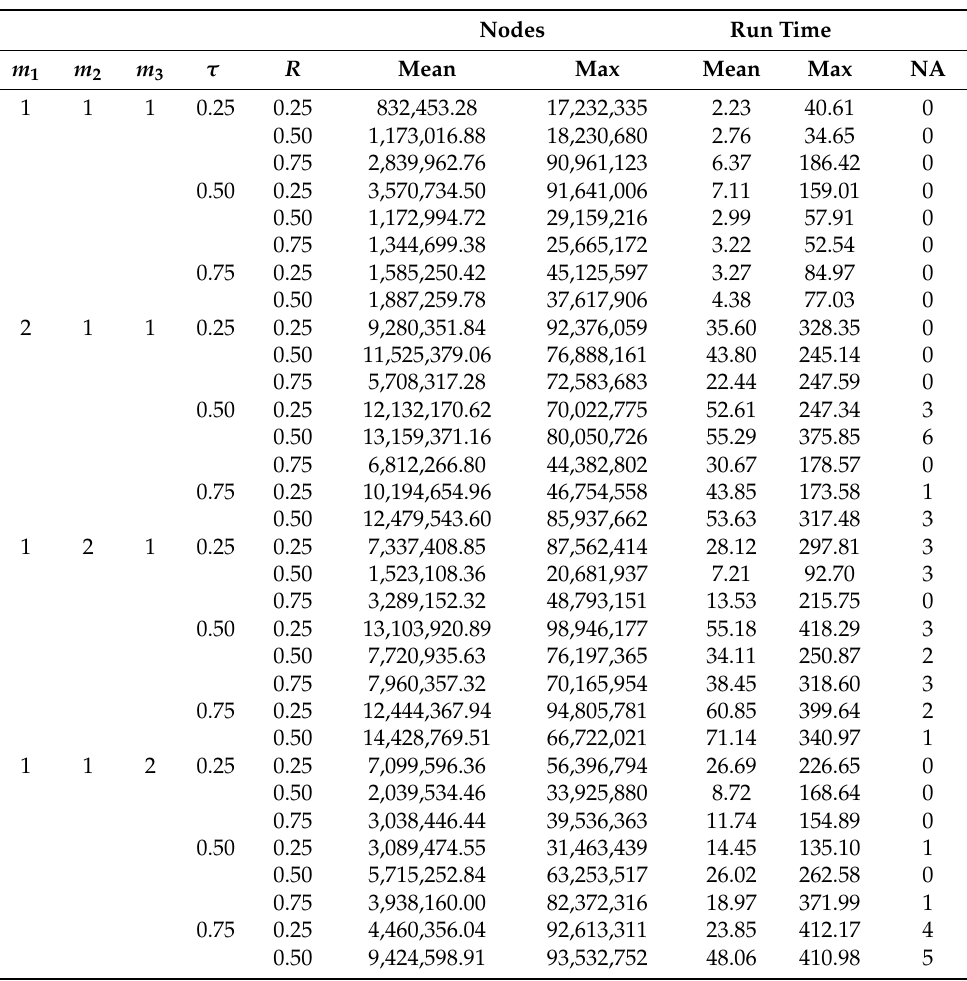
Table 6. The effects of different developers on the performance of BB for n = 15. Nodes Run